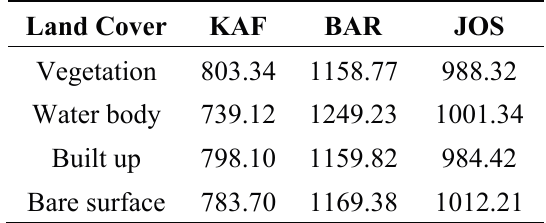
Figure 13. Landcover, LST, albedo, and topography in Jos in 2014. Table 11. Mean topography across landcover and regions.